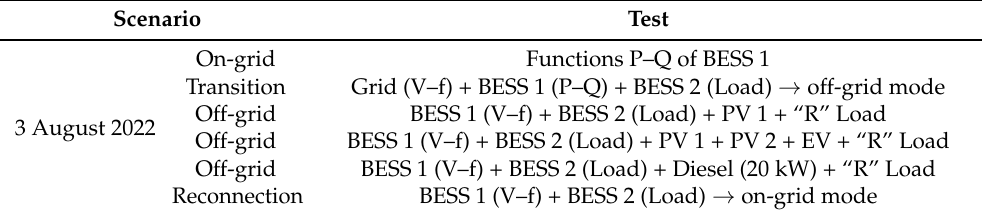
Table 6. Roadmap of tests carried out on the ITEMM